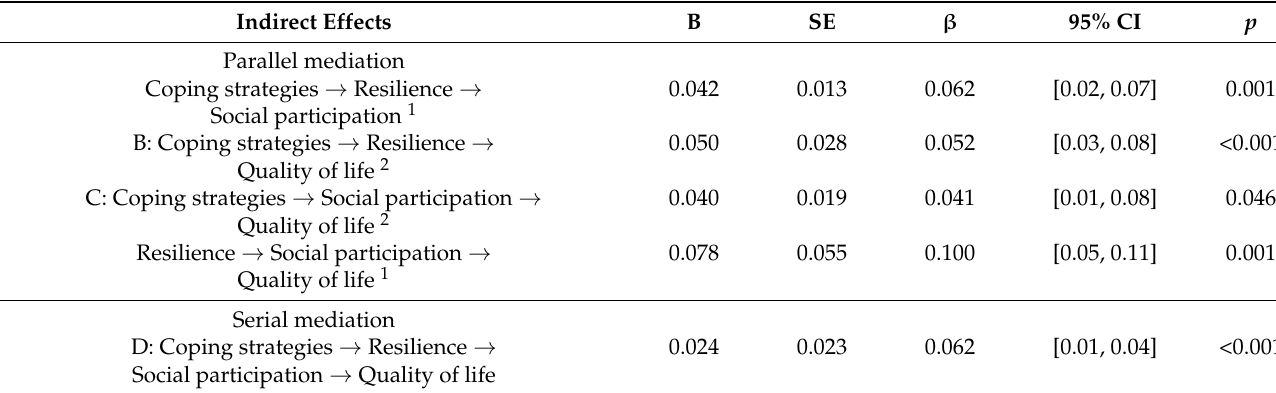
Table 4. Indirect effects of the predictor variables and